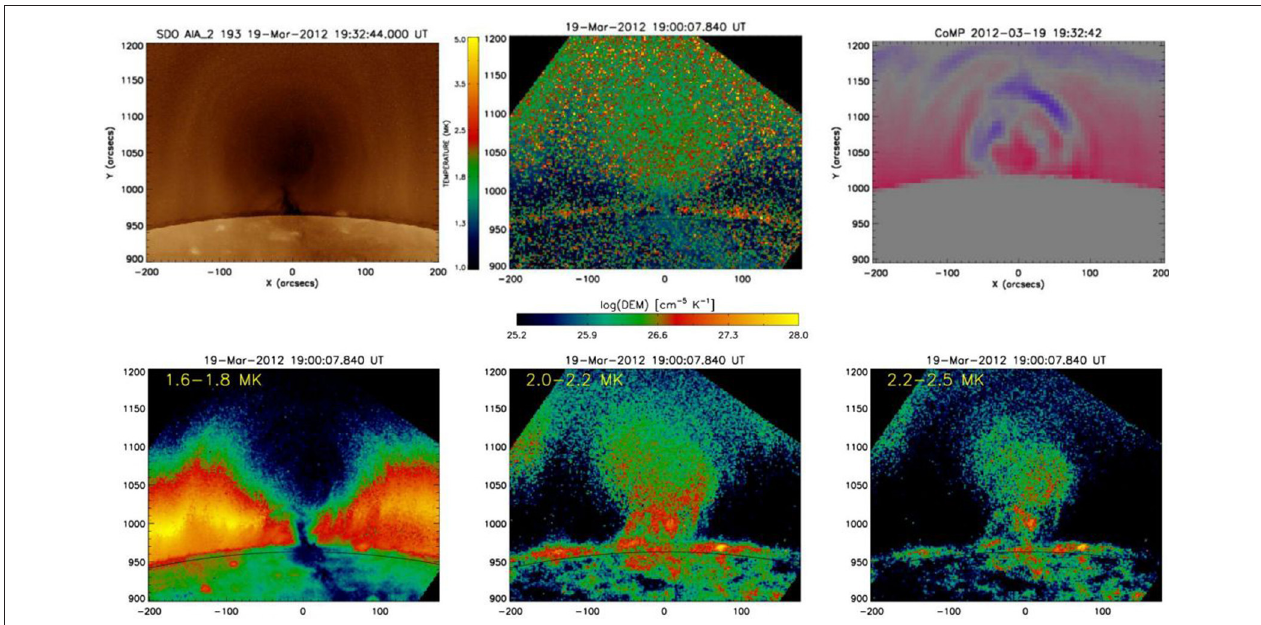
FIGURE 10 | Top:Left: Cavity observed on 2012 March 19 by SDO/AIA 193 Å. Middle: Maps of the DEM-weighted average temperature (calculated from Equation1). The position of the hot core is spatially correlated with the cavity and flows. Right : Doppler velocity from CoMP observations. Bottom : Emission measure in different temperature ranges.